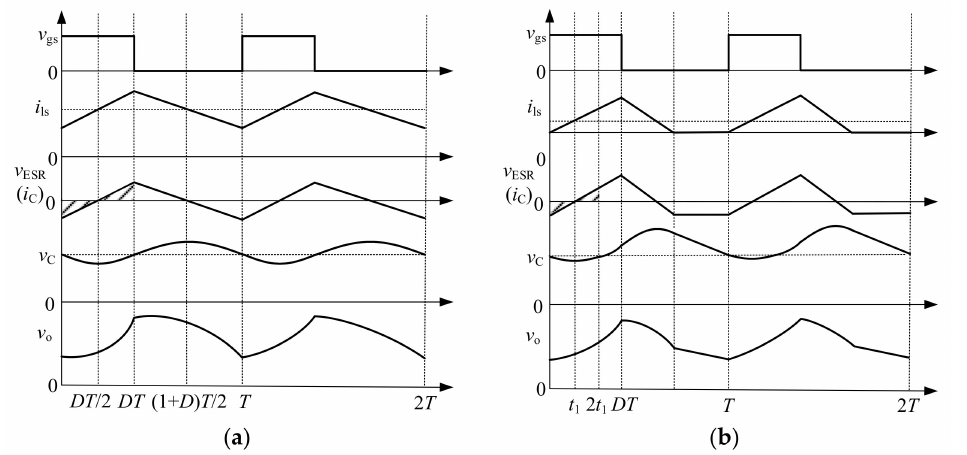
Figure 4. Representative waveforms of Buck converter: ( a ) continuous conduction mode (CCM); ( b ) discontinuous conduction mode